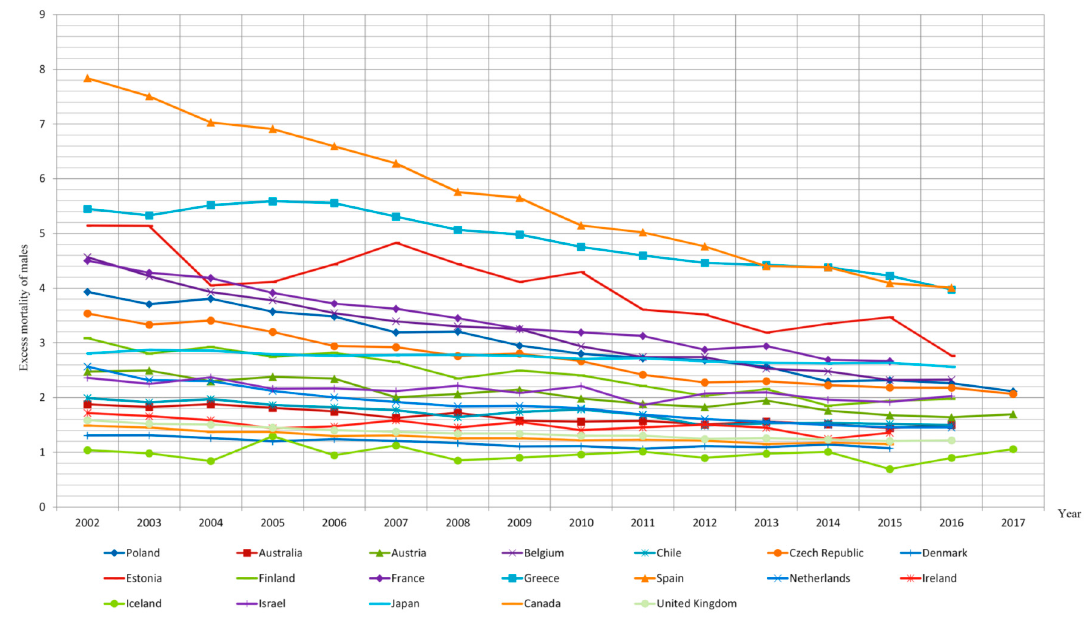
Figure 2. Excess mortality of males due to lung cancer in 18 selected OECD countries in 2002–2017.